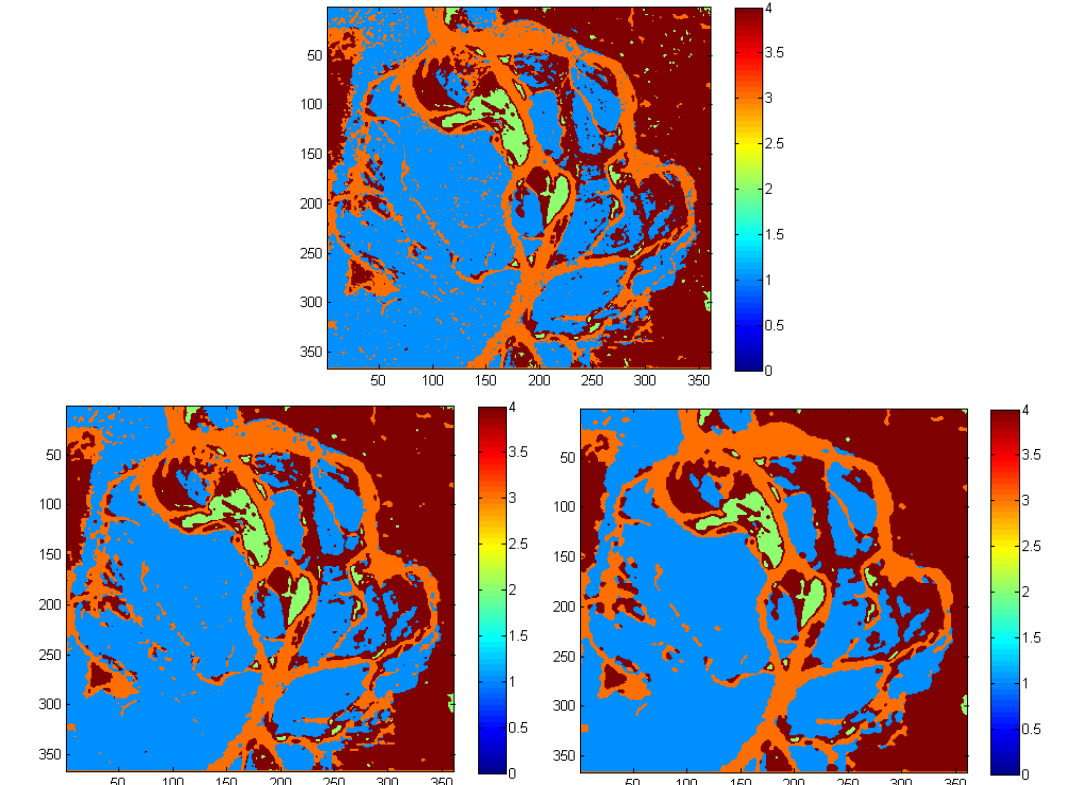
Figure 4. ( Above ) is the QDA classification. The lower figures are the classifications obtained using probability label relaxation ( left ) and Markov random fields ( right ), respectively, applied to the QDA